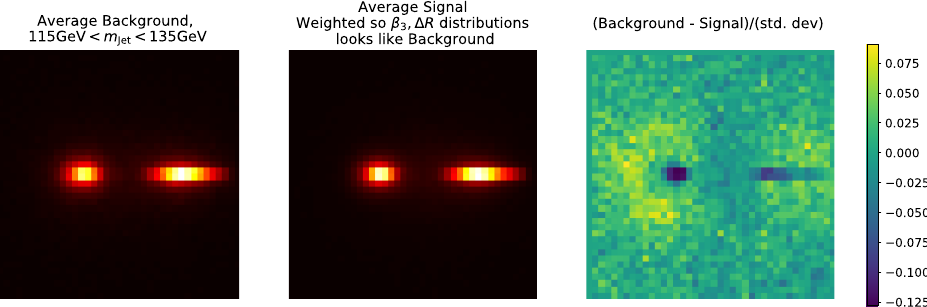
Figure 8 . Left (middle): the average background (signal) images after reweighting the (cid:12) 3 distribu- tion and the (cid:1) R (between b-tagged subjets) distribution in signal to be the same as in background. Right: the average di(cid:11)erence between the left and middle